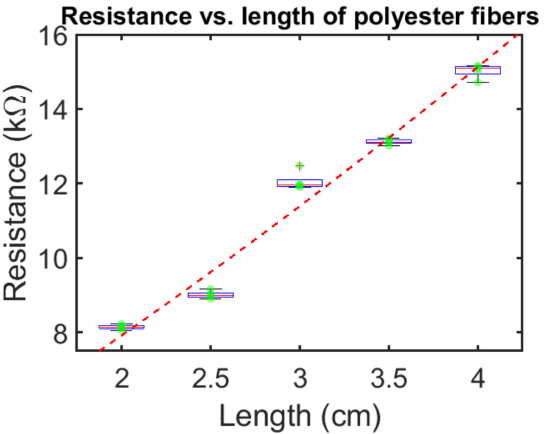
Figure 3. Resistance values of the polyester ECFs measured at f = 1 MHz, five times, with respect to the fiber length. Box plot with box of first and third quartile and median, and whiskers of minimum and maximum values, neglecting outliers. Outliers are denoted as